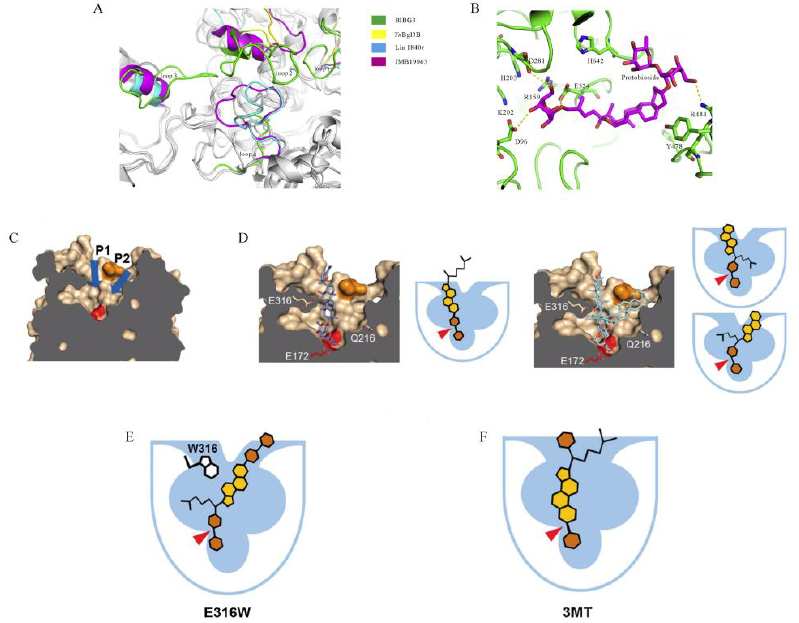
Figure 6. Structural analysis and rational mutagenesis of the acceptor- binding pocket of β -glucosidase [61,82] . ( A ) Structural comparison of BlBG3 with other GH3 family members: loops 1, 2 and 3 are present only in BlBG3 (green); ( B ) Compound protobioside (magenta) was docked to the active pocket of BLBG3; ( C ) The substrates were assumed to bind to the enzyme from Microbacterium sp. Gsoil 167 through both P1 and P2 paths; ( D ) Docking simulations of Rg3 (blue) and Gyp17 (cyan) are presented on the cross- section of the substrate binding cleft of β -glucosidase from Microbacterium sp. Gsoil 167; ( E ) Substrate binding modes of E316W; ( F ) Substrate binding mode of the 3MT (I184A/I389A/F390A) mutant.